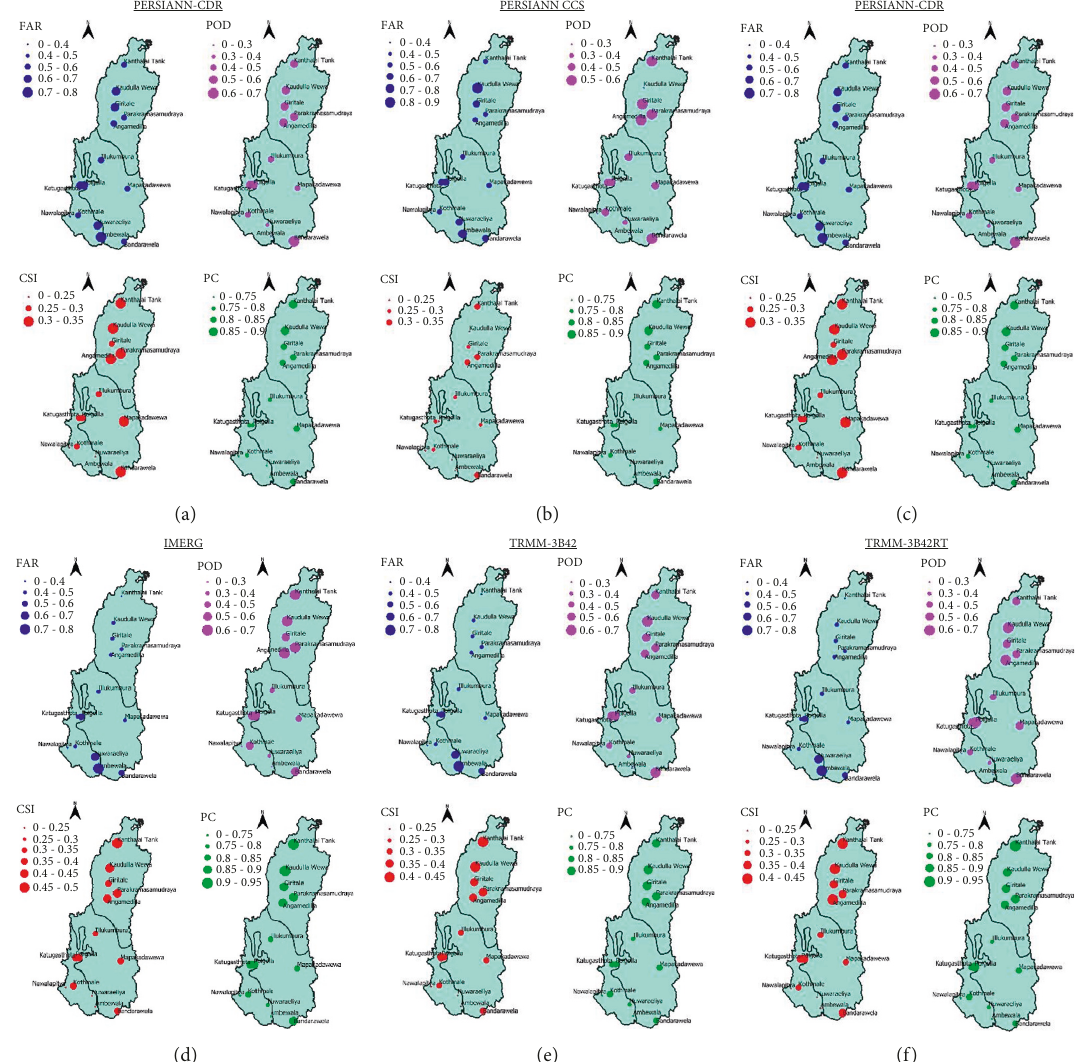
Figure 4: Categorical evaluation for heavy rainfall events. (a) For PERSIANN. (b) For PERSIANN-CCS. (c) For PERSIANN-CDR. (d) For IMERG. (e) For TRMM-3B42. (f) For